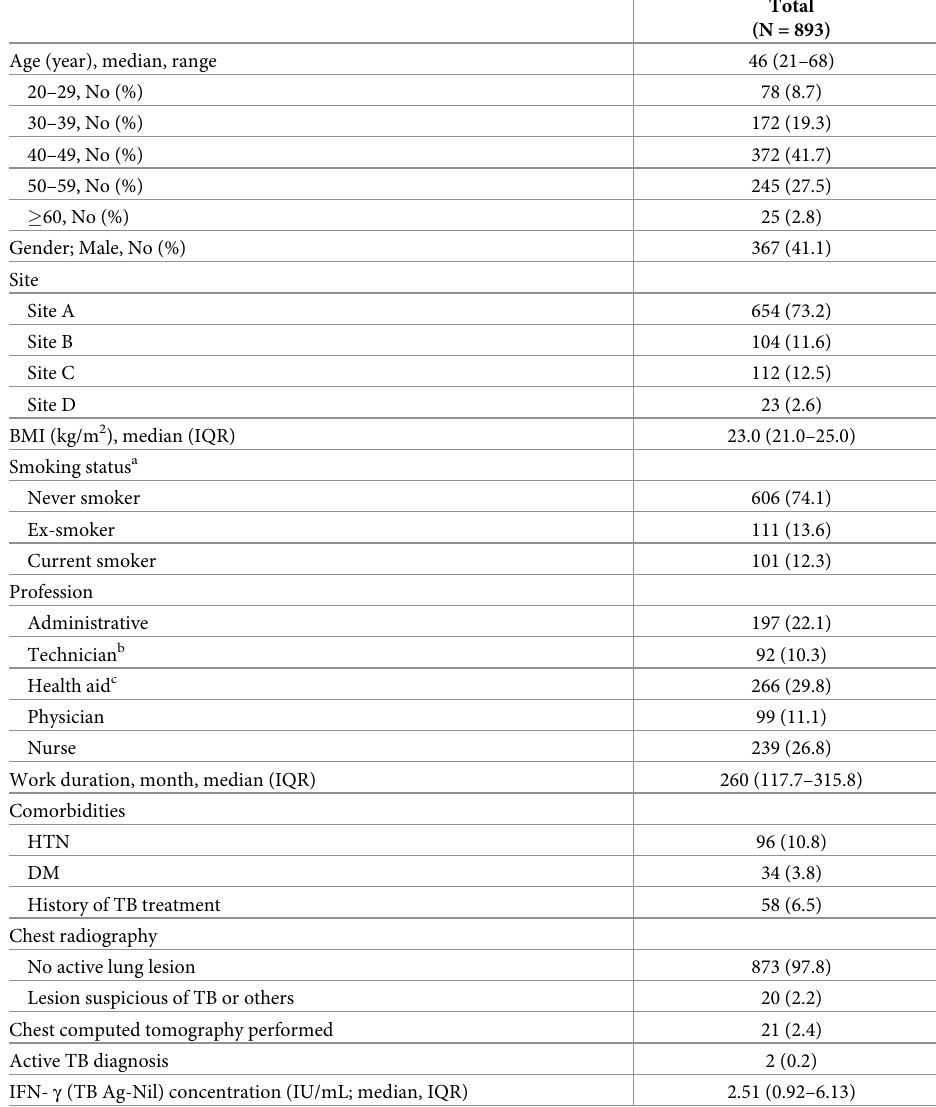
Table 1. Baseline characteristics IGRA positive